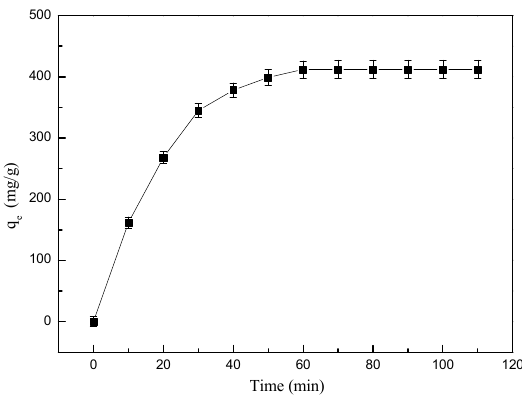
Figure 11. Time-dependent adsorption behavior of MGO@ZIF-8.